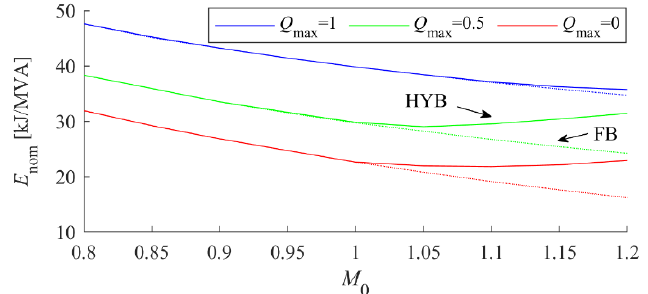
Figure 11. Capacitor usage of hybrid MMC varying with M 0 and Q max .